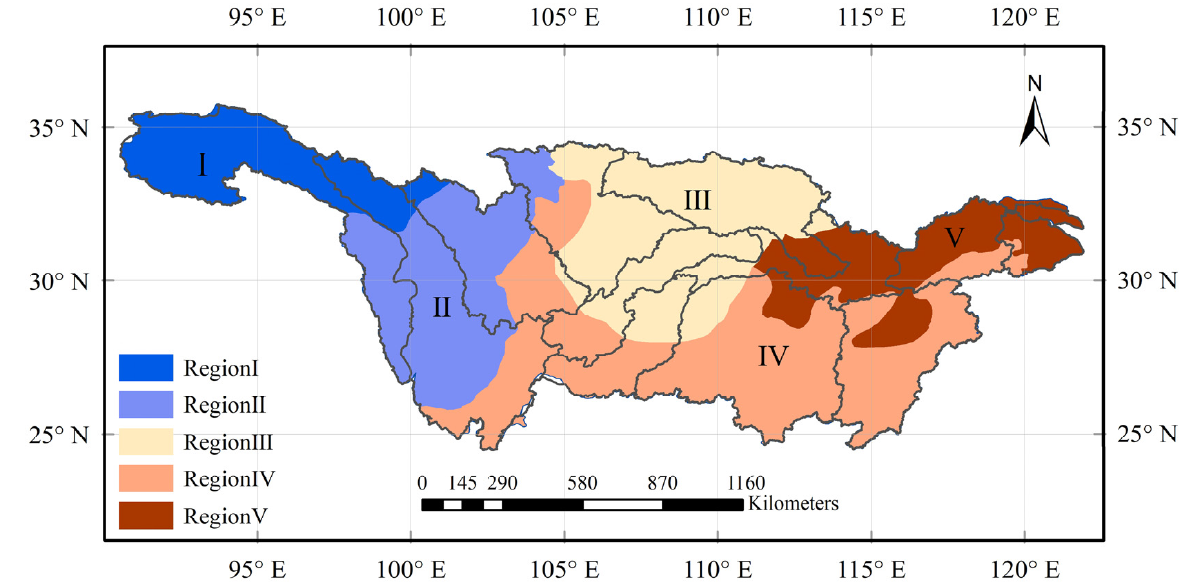
Figure 7. Spatial regionalization of vegetation changes.